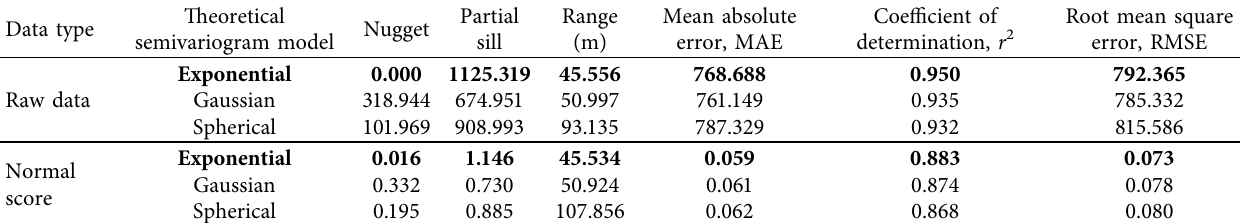
Table 1: Parameters and metrics of accuracy derived from theoretically-fitted experimental semivariograms.